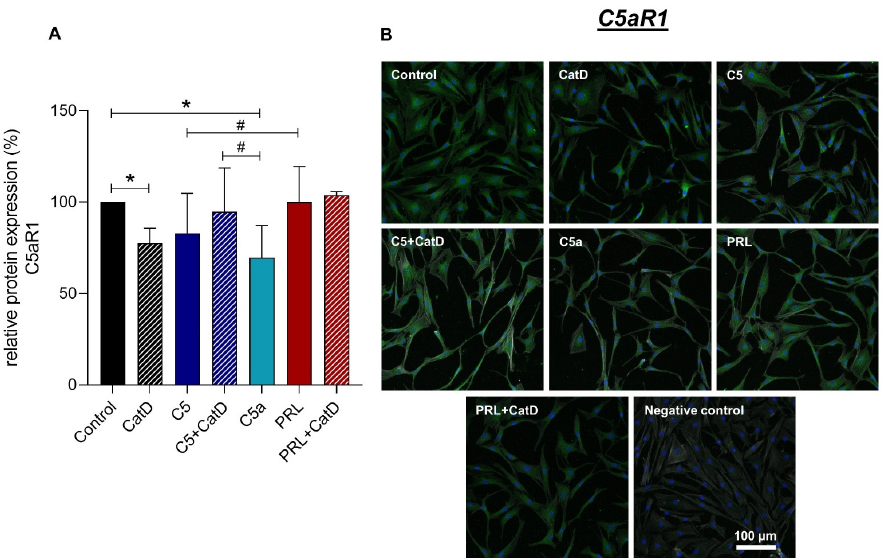
Figure 6. Chondrocytes protein expression of C5aR1 after 72 h of stimulation and negative control of the staining. n = 4 independent experiments with chondrocytes from different donors. ( A ): Graphic representation of relative C5aR1 protein fluorescence intensity, mean with standard deviation. Control has been normalized to 1. One sample t-test with significance in relation to control (*). Mixed-effects analysis using post-hoc Tukey’s multiple comparisons (#). */# = p ≤ 0.05. ( B ): representative images of chondrocytes immunolabeled with C5aR1 specific antibodies. Green (Alexa Fluor 488) = C5aR1, Cells 2022 , 10 , x FOR PEER REVIEW blue (DAPI) = cell nuclei, grey (Phalloidin Alexa 633) = Actin cytoskeleton. Scale bar = 100 µ m.